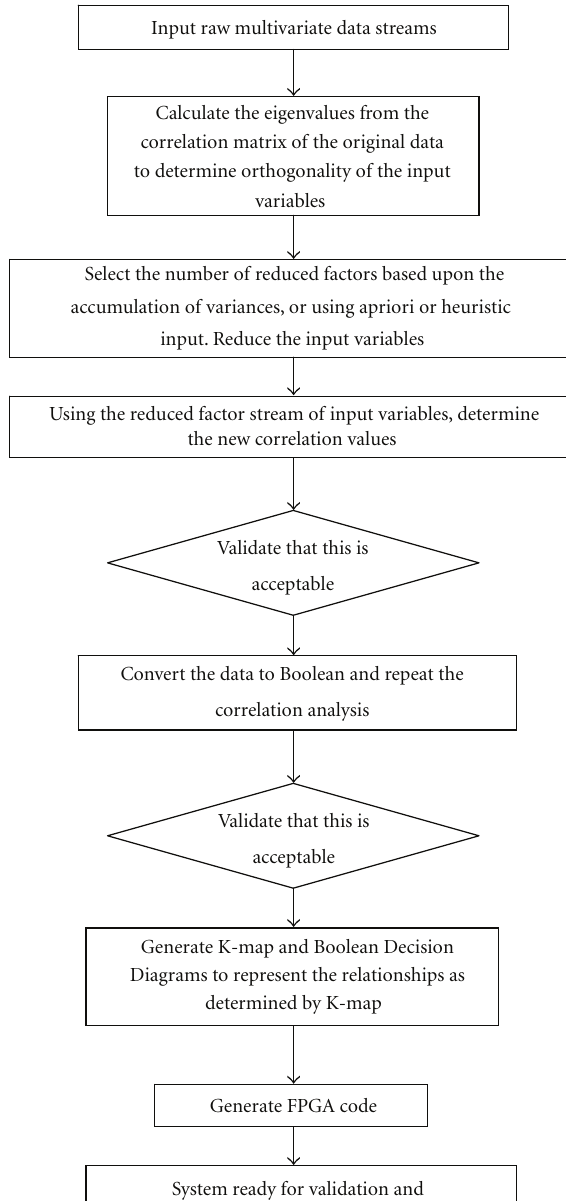
Figure 3: Flowchart for the proposed